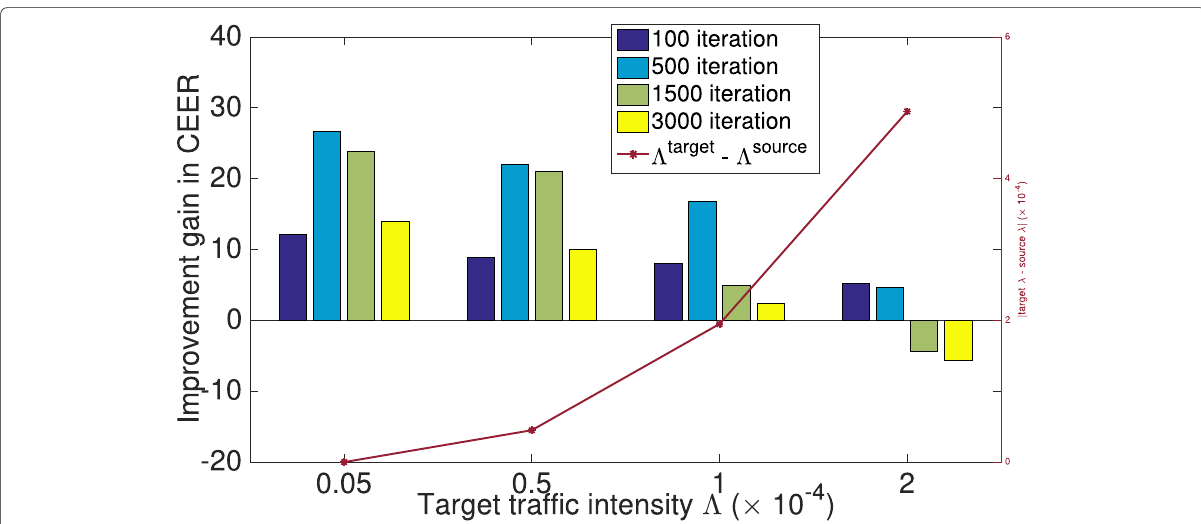
Fig. 5 Improvement gain of TLEEM-UCB policy w.r.t. EEM-UCB policy for different target arrival rate. The figure shows the percentage of improvement in CEER while using transfer learning w.r.t. to non-transferred knowledge algorithm. The bars corresponding to the left Y -axis reflect the gain in CEER while the right Y -axis represents the difference (cid:2) target − (cid:2) source . The performance gain is plotted for several number of iterations, i.e., 100, 500, 1500, and